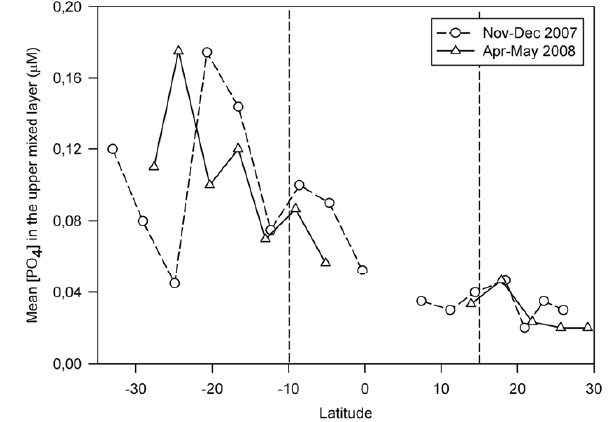
Fig. 4. Latitudinal distribution of mean phosphate concentration in the upper mixed layer during the 2007 (circles) and 2008 (triangles) cruises.